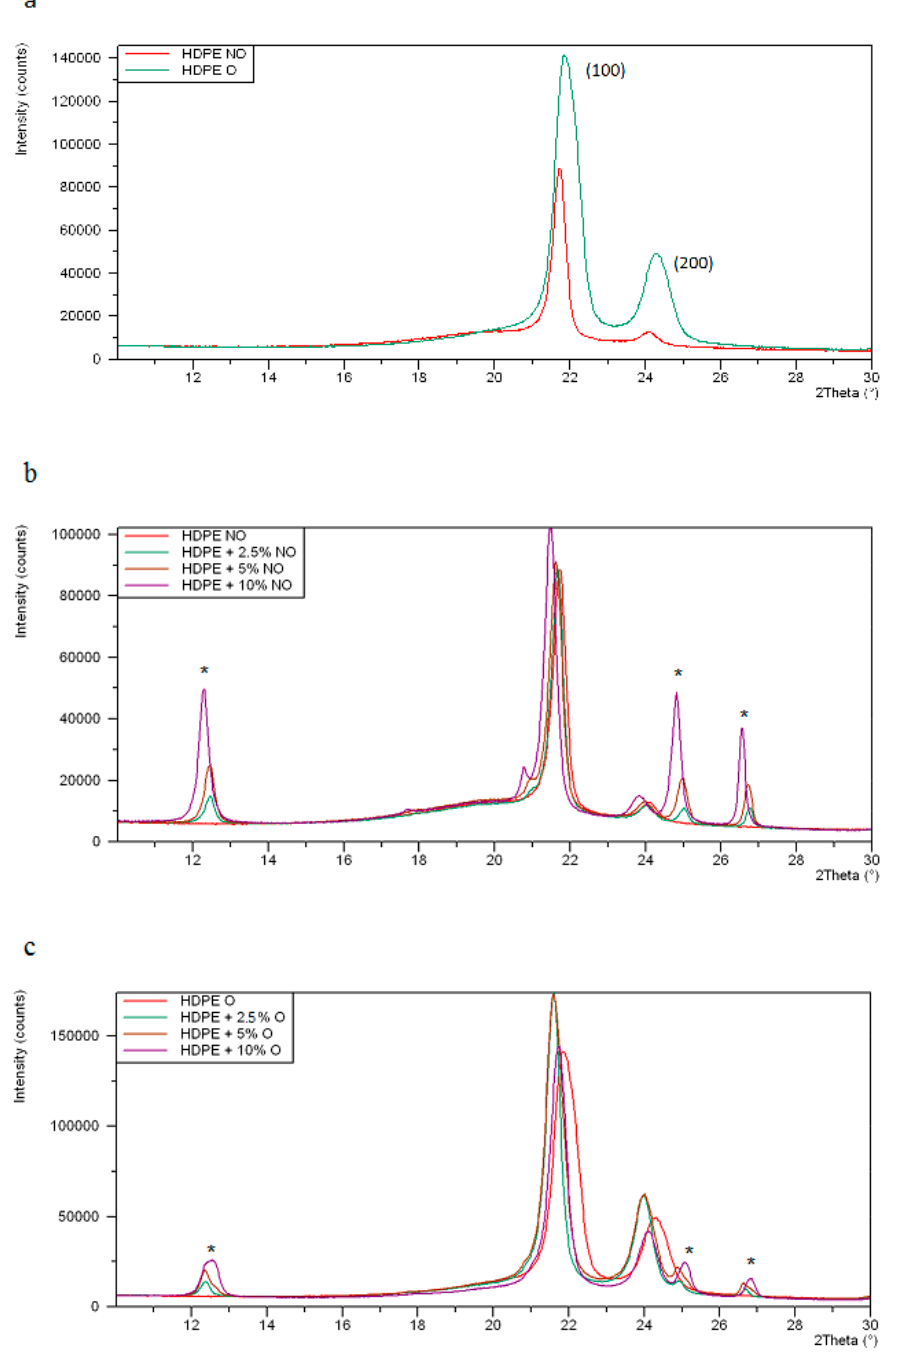
Figure 4. XRD patterns of HDPE ( a ), and its composites with 2.5%, 5% and 10% filler: non-oriented (NO) ( b ) and oriented (O) ( c ). The asterisks mark the signals from the filler. In XRD patterns of HDPE and MDPE composites, the signals attributed to Sillikolloid P87 are also seen and their intensities increase with the increase of its content in the sample. Unmodified HDPE is characterized by a slightly higher degree of crystallinity than for neat MDPE (Table 1). Sillikolloid P87 added to HDPE reduces its X value by about 6–7%.